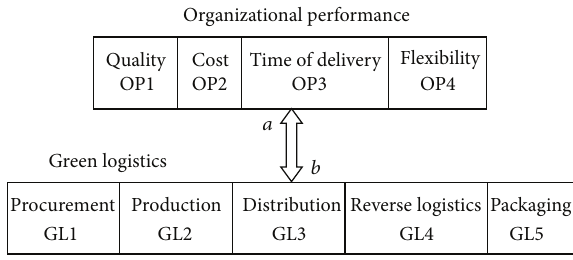
Figure 2: Conceptual network 1: “Organizational Performance” and “Green